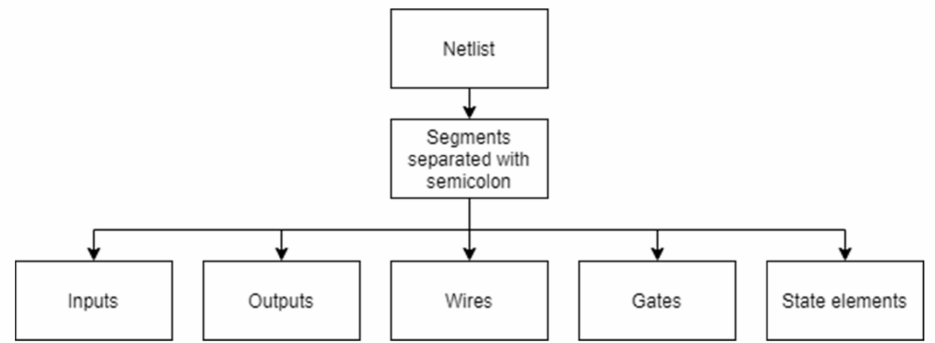
Figure 3. Parsing process of the netlist.